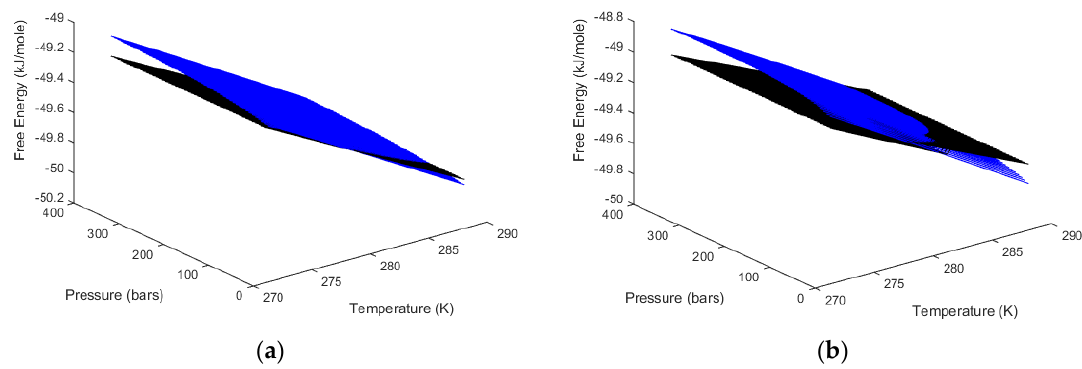
Figure 8. ( a ) Free energy of aqueous solution of CH 4 (blue) and free energy of CH 4 hydrate at stability limit towards liquid water (black). ( b ) Free energy of aqueous solution of CO 2 (blue) and free energy of CO 2 hydrate at stability limit towards liquid water (black). These contours illustrate the thermodynamic driving forces for hydrate formation from solution. The black contours are not the free energy of the hydrates but the free energy benefits for creating hydrate for the specific concentrations of hydrate formers in water as given in Figure 7.